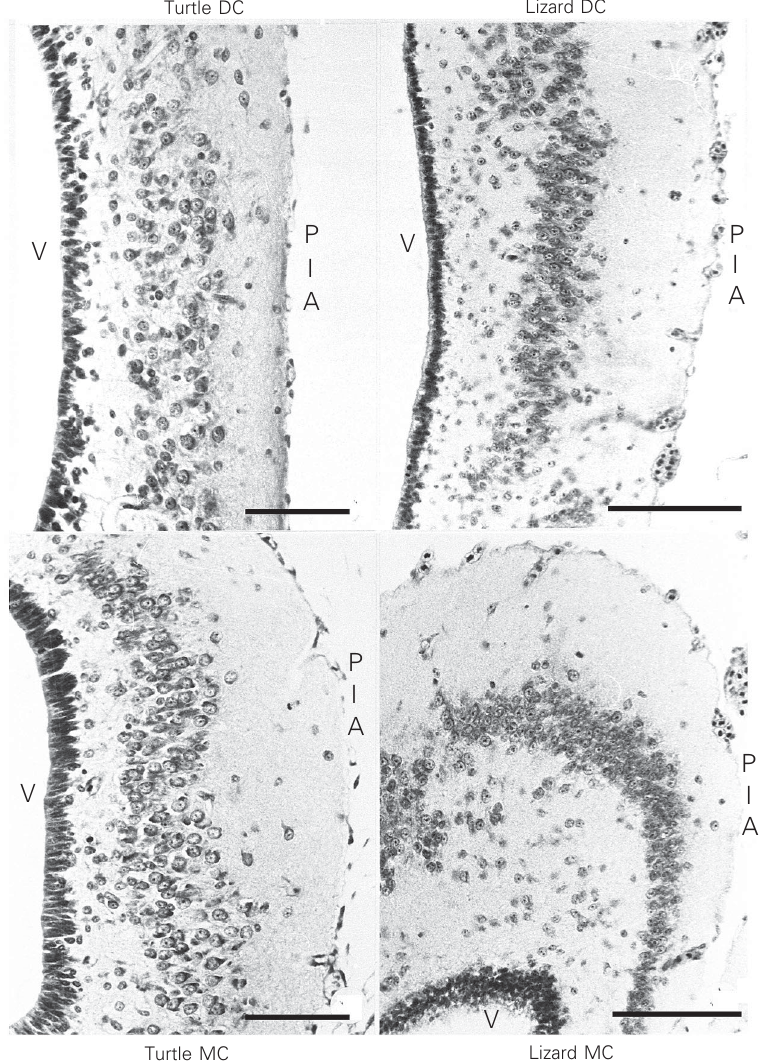
Figure 3. Comparison of embryonic cortical organization in turtles and lizards at the level of the medial (MC) and dorsal cortex (DC). The rudimentary architectonics of the turtle cortical plate stands in contrast to the elaborate differentiation of the lizard cortex. PIA: pial surface; V: ventricle. HE stain. Adapted from Refs. 2 and 16. Magnification bars: 100